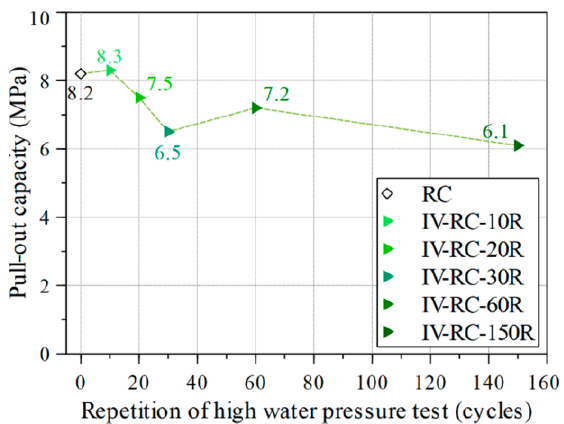
Figure 15. Pullout capacity versus the number of cycles of high water